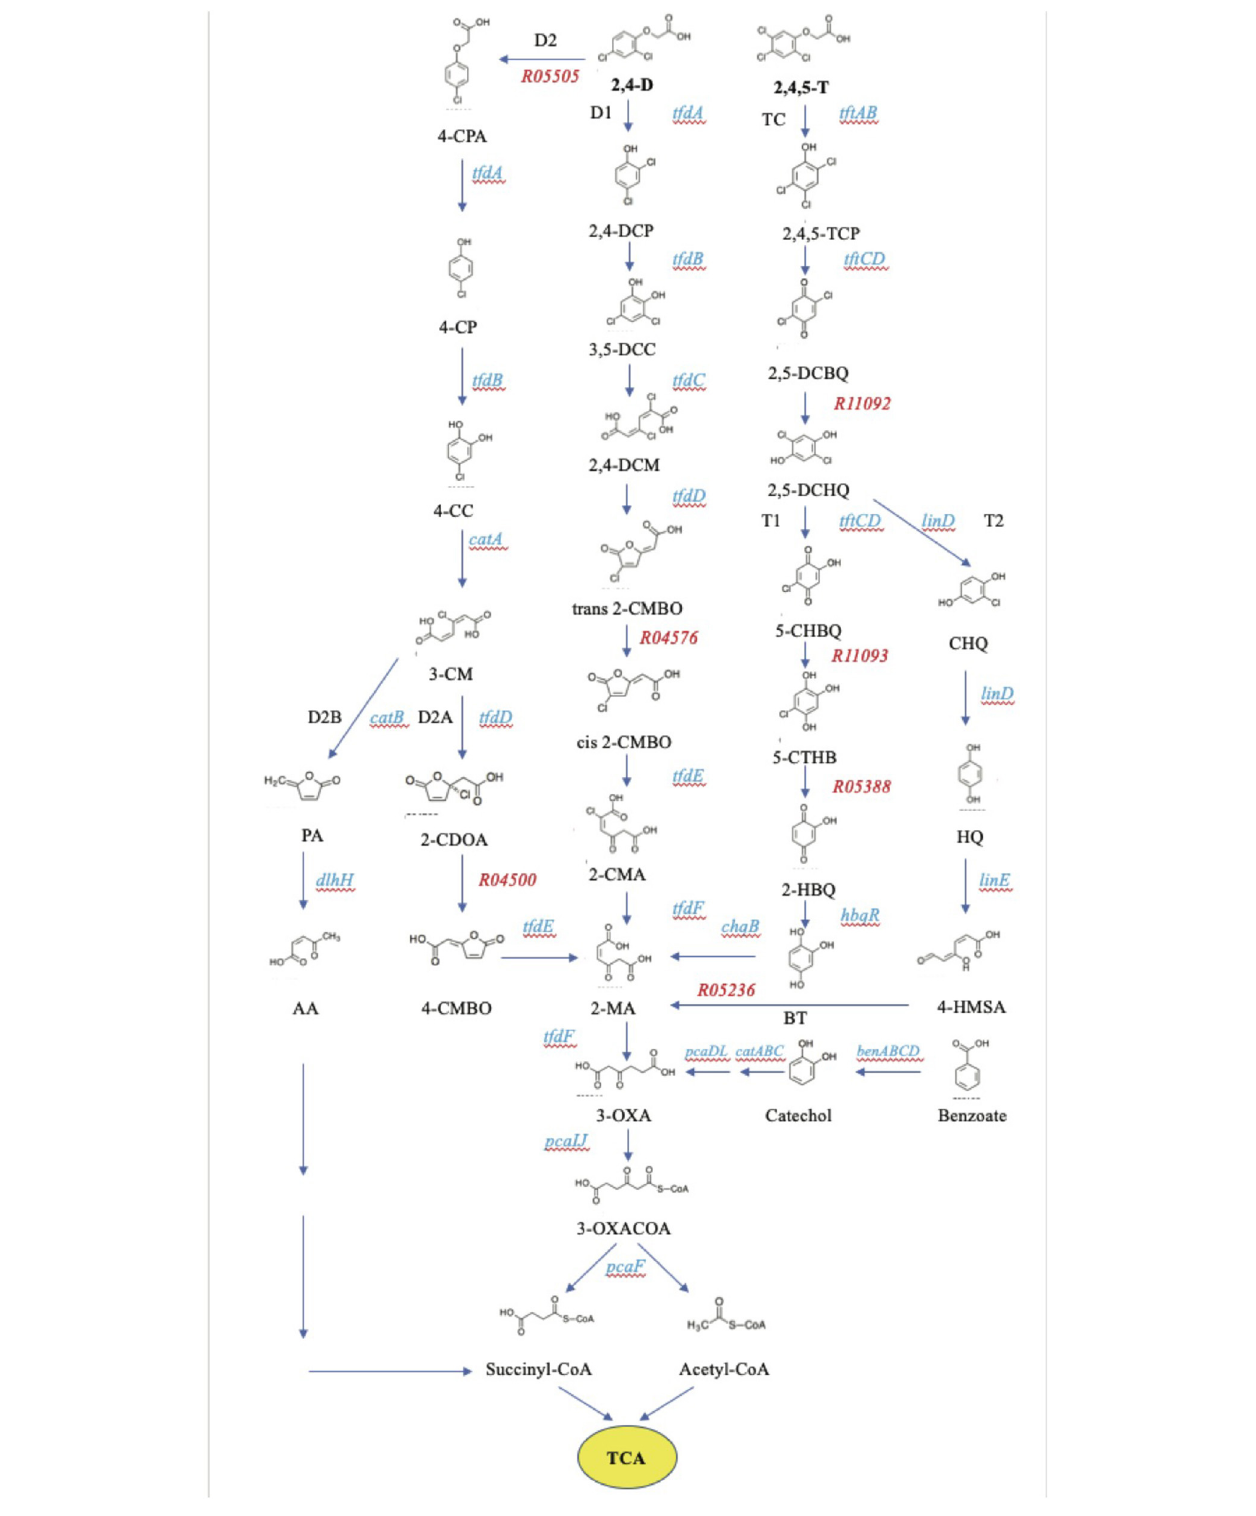
FIGURE 4 | KEGG pathways for the degradation of 2,4-D and 2,4,5-T. Genes encoding the enzymes in the pathways are listed in Supplementary Table 1 .